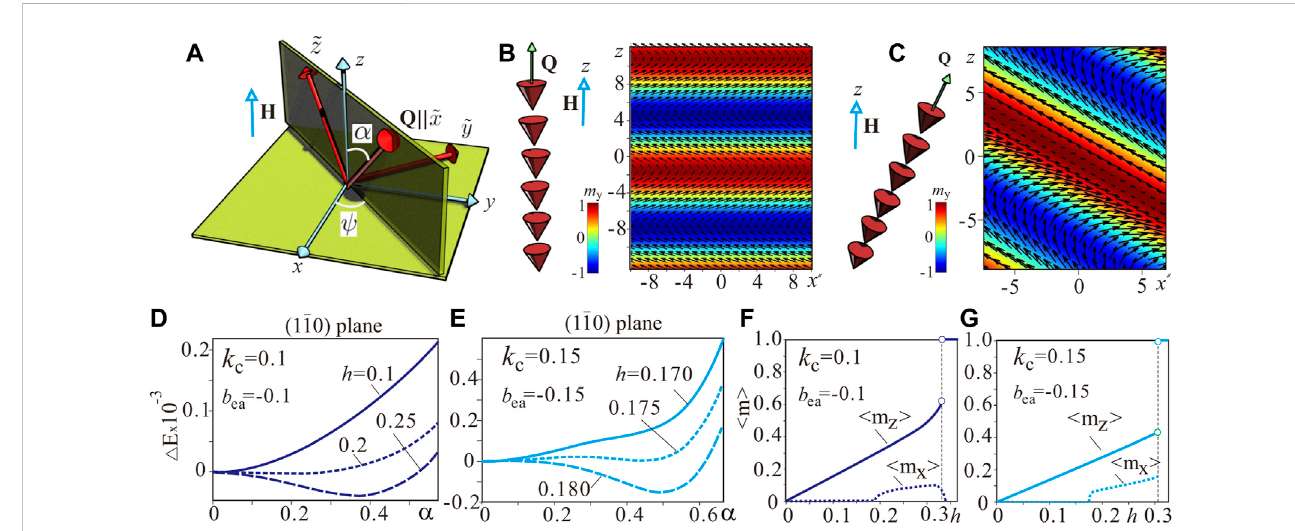
FIGURE 2 (coloronline) (A) Schematicsofacoordinatesystemtoaddressnumericallytwo-dimensionaltiltedspiralstates.TheenergydensityiswritteninanewCS ( ~ x , ~ y , ~ z ) andisminimizedwithrespecttotheangles ψ and α . (B) , (C) Contourplotsforthecomponents m y ofthemagnetizationvector plottedintheCS( x , y , z ) alongsidewiththesketchesofthecorrespondingone-dimensionalspiralstates — cones (B) andtiltedspirals (C) . (D) , (E) Energydensityplottedasafunctionof the tilt angle α in the ( 1 10 ) plane for two representative sets of anisotropy coef fi cients and for several fi eld values indicating the transition into the tilted spiralstate: (D) k c =0.1, b ea = − 0.1; (E) k c =0.15, b ea = − 0.15. (F) , (G) Magnetizationcurves,whichimplytheexistence regionofthetilted spiralbythenon-zero magnetization component 〈 m x 〉